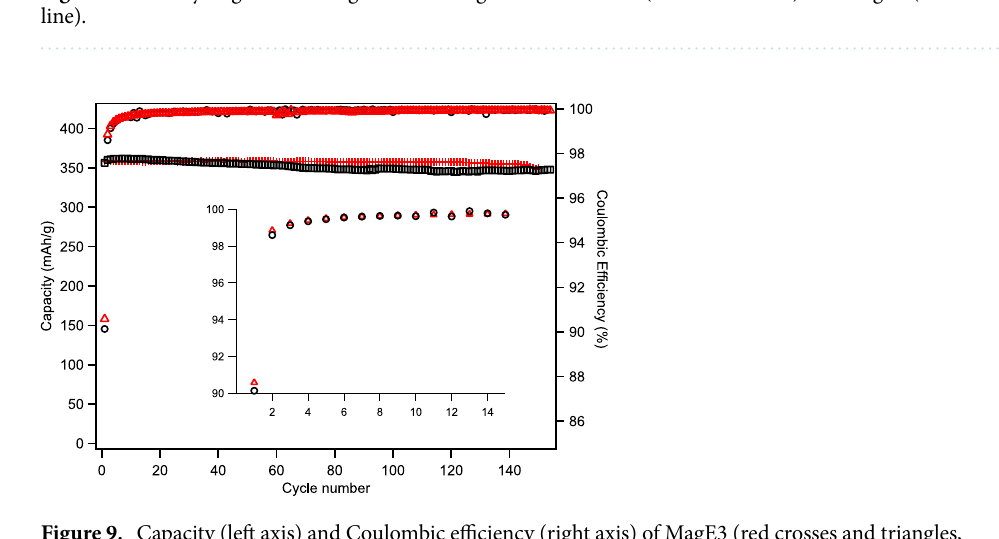
Figure 9. Capacity (left axis) and Coulombic efficiency (right axis) of MagE3 (red crosses and triangles, respectively) and sBCG (open black squares and circles, respecively) plotted as a function of charge/discharge cycles. Inset is an expanded plot of Coulombic efficiency of the first 15 cycles with scale on left